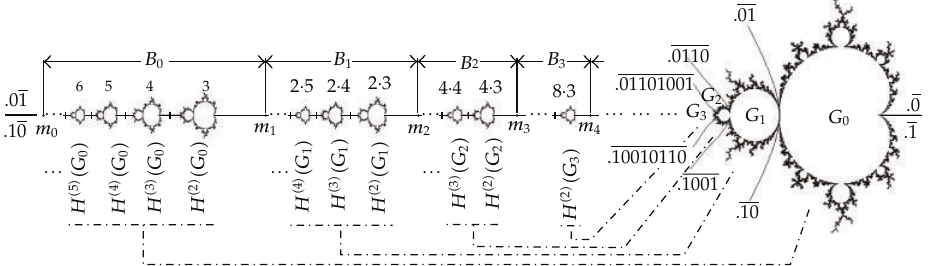
Figure 2: Mandelbrot set showing the main cardioid G 0 with the period doubling cascade G 1 , G 2 , G 3 ,... and a sketch of the antenna with the first four chaotic bands B 0 , B 1 , B 2 , and B 3 separated by the merging points m i . Each HC of B i can be obtained by the successive harmonics of G i